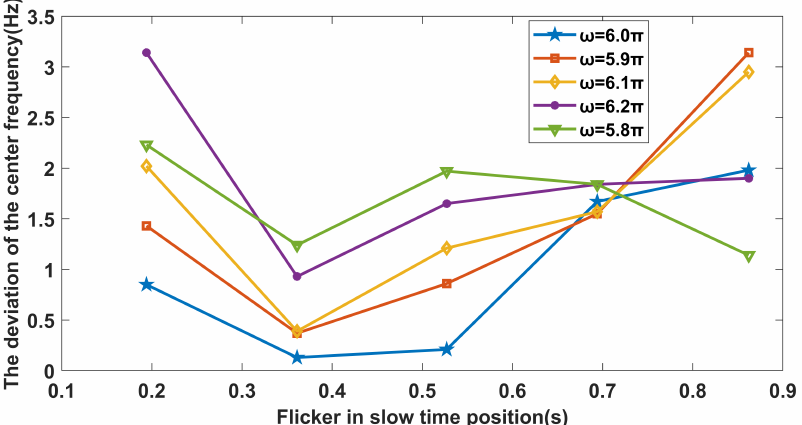
Figure 11. The effect of different angular frequency compensation phases on flicker